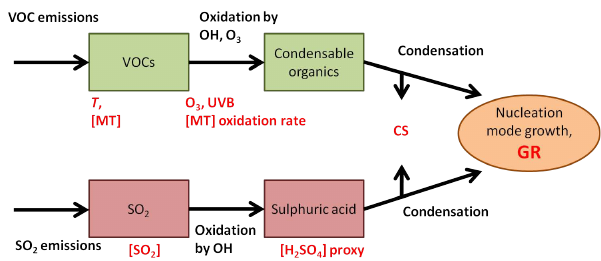
Fig. 1. A schematic connecting the studied long-term datasets of atmospheric parameters (temperature T , O 3 , UVB radiation, monoterpene concentrations MT, condensation sink CS, SO 2 , sul- phuric acid proxy, in bold red) to the concentrations of VOCs and SO 2 , and the processes (emission, oxidation, condensation, in bold black) leading to nucleation mode particle growth rates